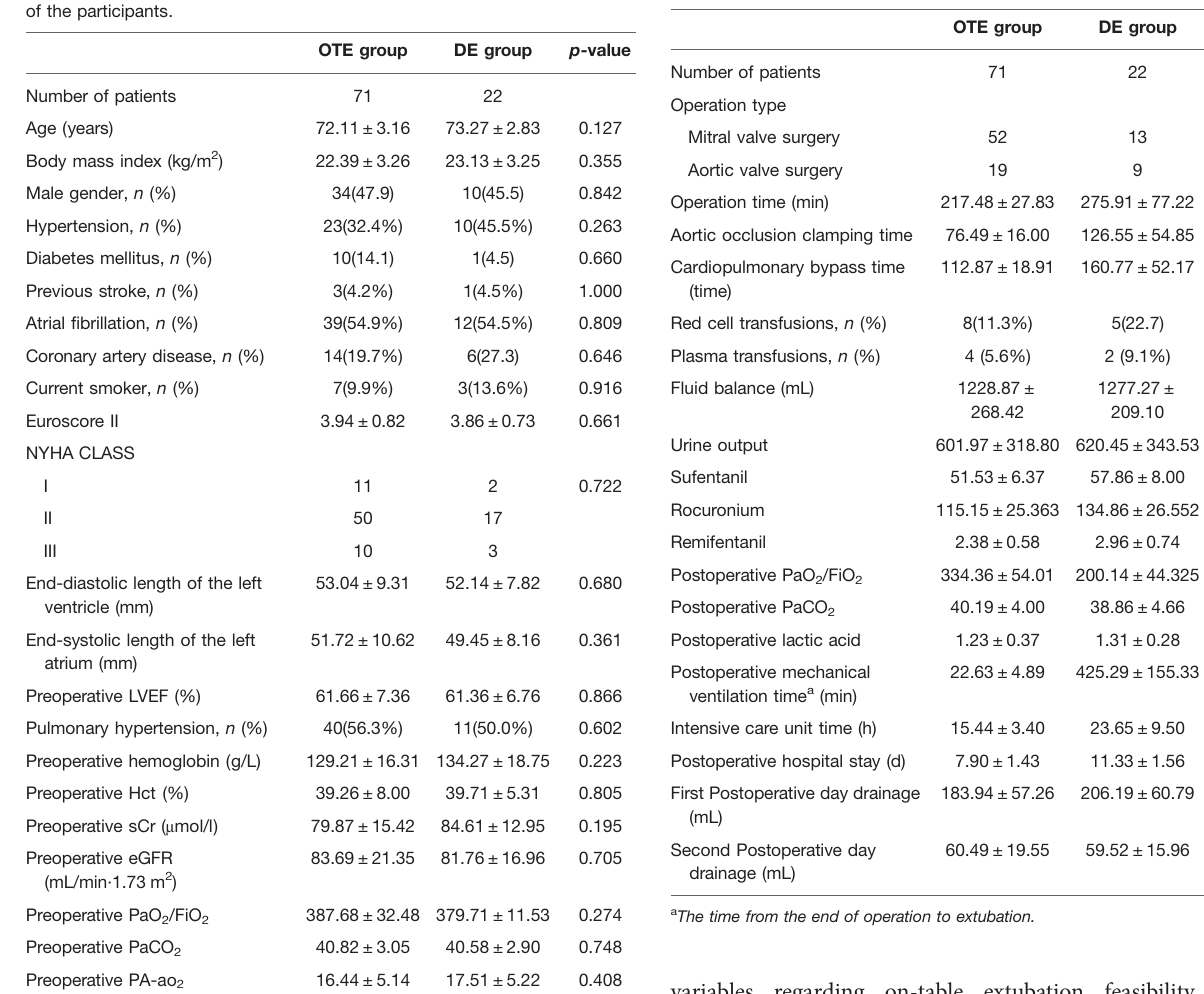
TABLE 2 | Intraoperative parameters and postoperative parameters. TABLE 1 | Demonstrates a comprehensive list of preoperative characteristics